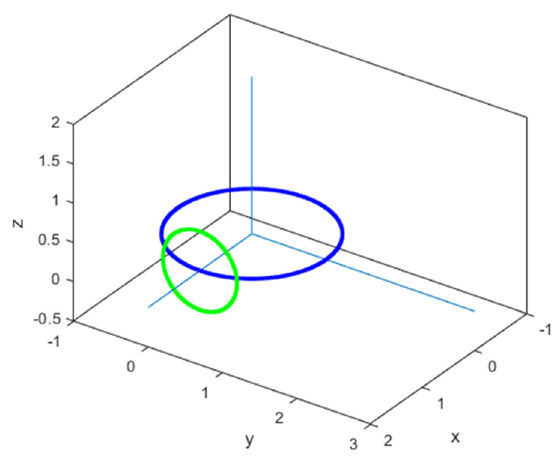
Figure 6. Case (b): two perpendicular circular loops. Not a singular case, ( a = 1, b = c = 0, L = l = 1).